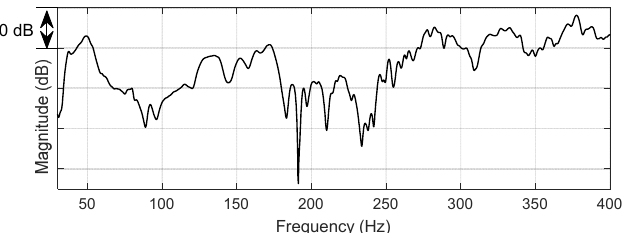
Figure 7. A measured magnitude response of the secondary path of the PZT ‐ plate actuator.